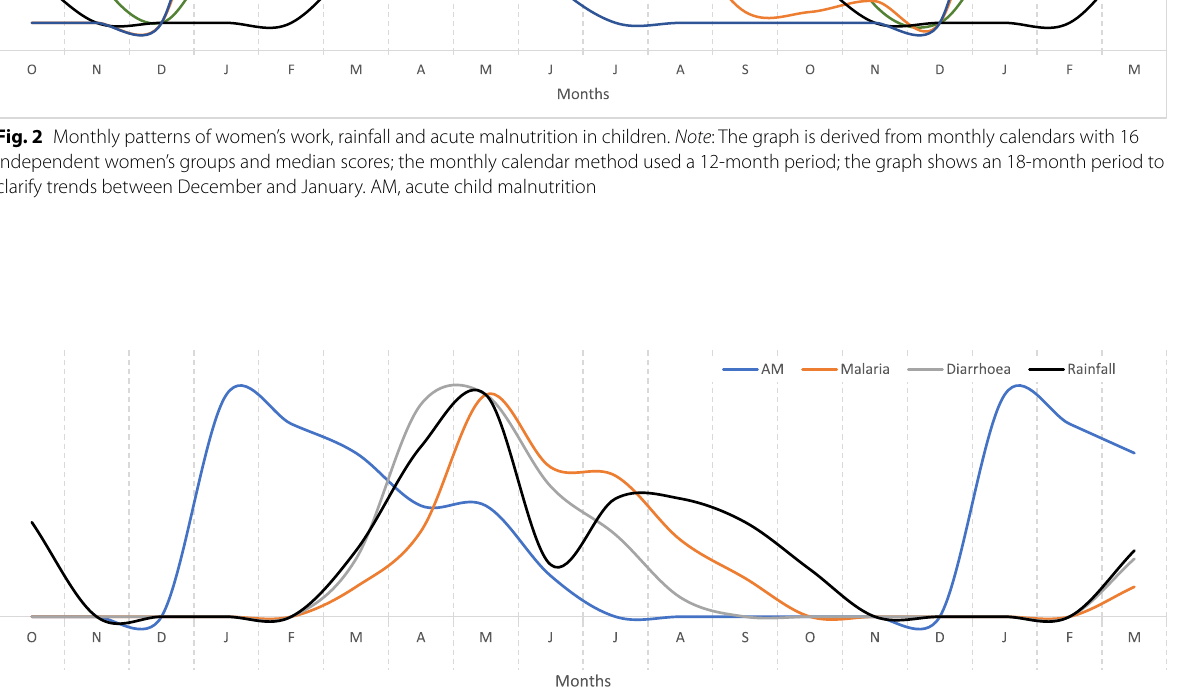
Fig. 3 Monthly pattern of malaria, diarrhoea, rainfall and acute malnutrition in children. Note : The graph is derived from monthly calendars with 16 independent women’s groups and median scores; the monthly calendar method used a 12-month period; the graph shows an 18-month period to clarify trends between December and January. AM, acute child